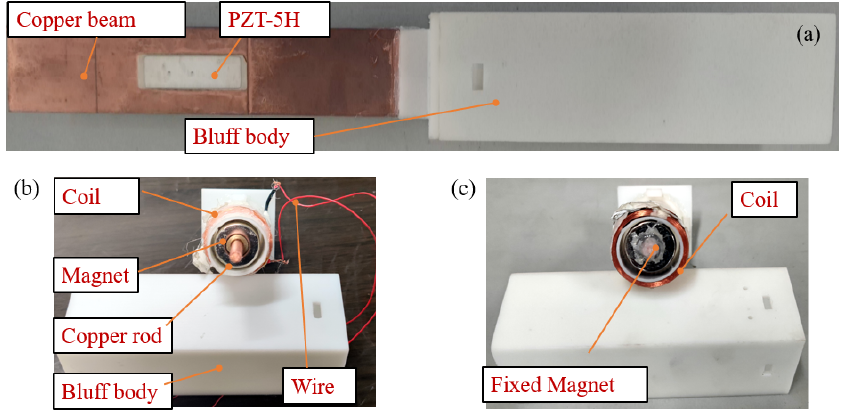
Figure 12. ( a ) The overall GPEEH ( b ) The split GPEEH ( c ) The split CGPEH.